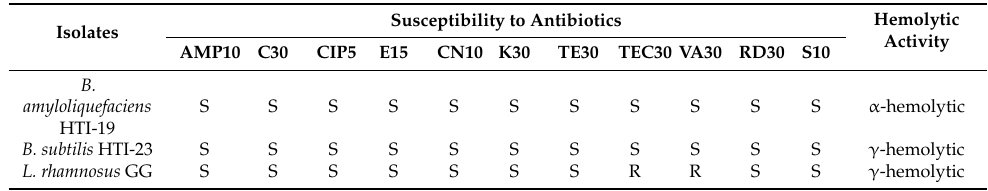
Table 5. Antibiotic susceptibility of Bacillus isolates to antibiotics. Antibiotics: AMP10